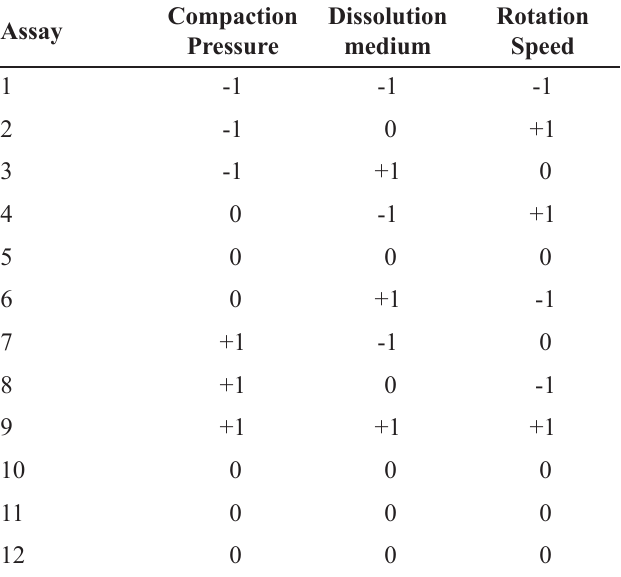
TABLE II - Description of assays using coded levels (-1, 0, +1) for each of the factors employed in the fractional design for intrinsic dissolution tests of amlodipine